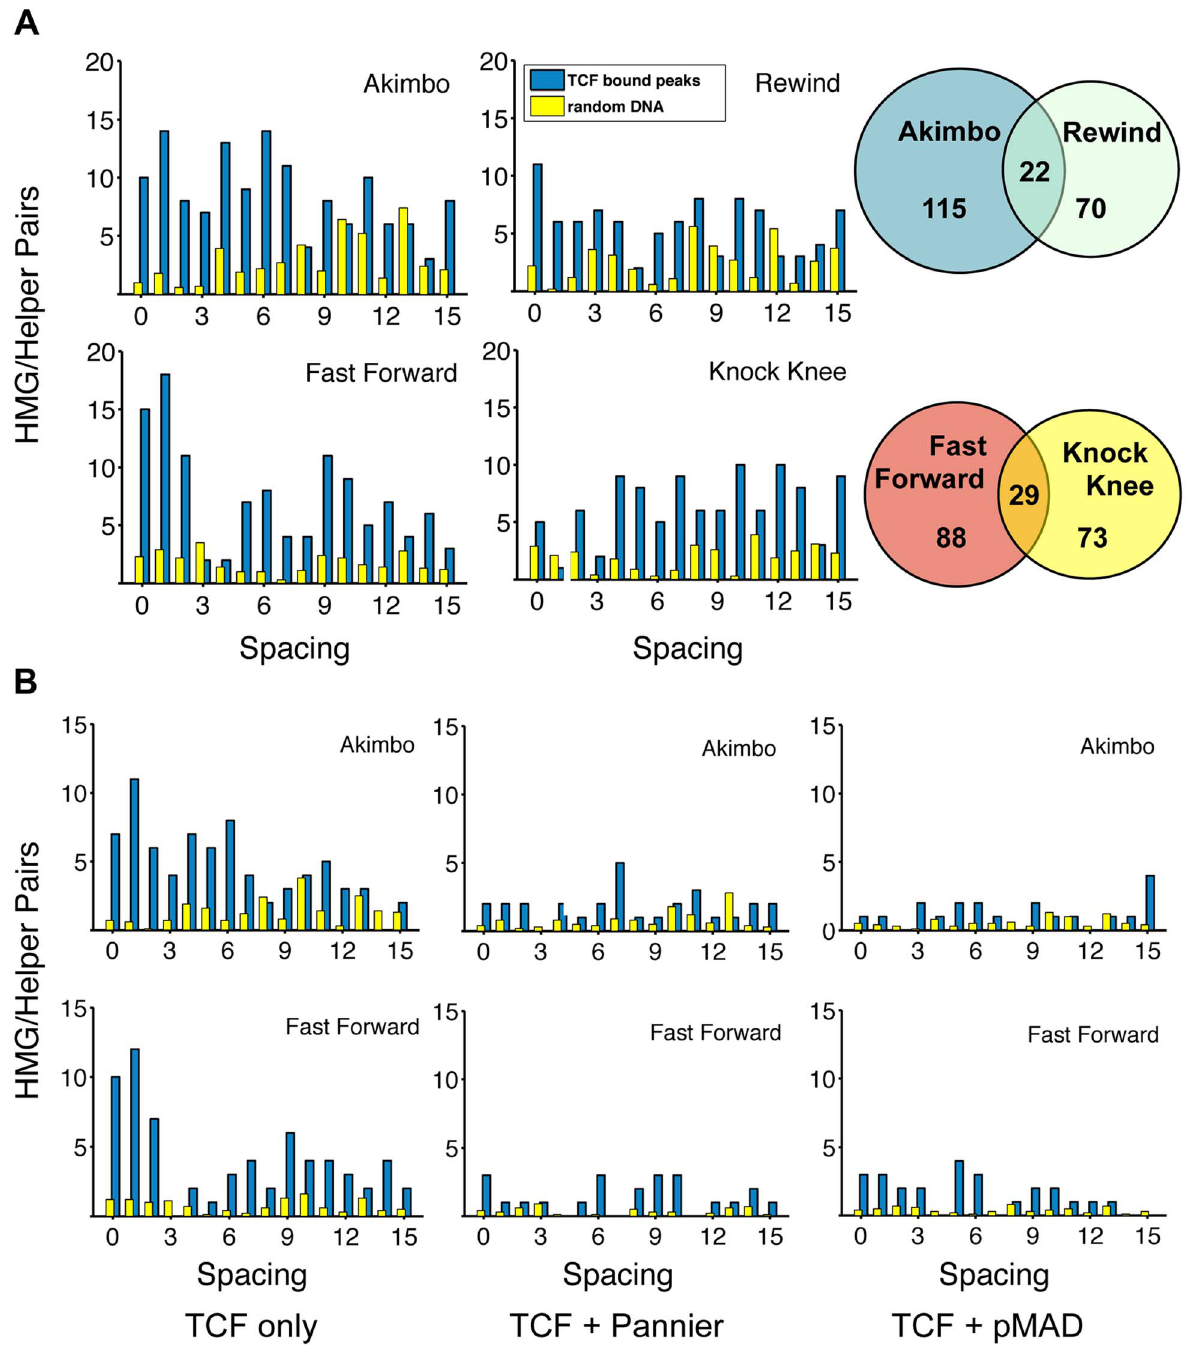
Figure 6. TCF/Pan-bound chromatin is enriched for HMG-Helper site pairs. (A) Distribution of HMG-Helper pairs in genomic sequences bound by TCF/Pan (blue bars) versus random DNA (yellow bars). TCF/Pan-bound sequences were obtained from a ChIP-seq data set from germband extended Drosophila embryos [28]. Equivalent amounts of random DNA from intergenic, intronic and 5 9 /3 9 UTR regions were analyzed, with the average of ten such runs displayed. Nearly all the HMG-Helper site configurations were enriched in TCF/Pan bound regions, with the highest degree of enrichment in FF0-2 and AK0-6. Due to the semi-palindromic nature of the Helper site, many sites with nucleotide mismatches were called as both AK/RW or FF/KK. The overlap is indicated in the Venn diagram to the right of each pair of graphs. (B) AK and FF motifs are highly enriched in peaks which are uniquely bound by TCF/Pan (see text for further explanation). Enrichment is less dramatic in TCF/Pan peaks that are shared by Pannier or indirectly effects expression of the W-CRM reporter. This is nearly complete loss of reporter expression (Figure 8B 9 ). In addition to its role in Wg signaling, Arm is also required for cell unlikely, because da Gal4 . UAS arm RNAi embryos were morpho- adhesion [69,70], raising the possibility that depletion of Arm logically normal at stage 13 and had normal expression of Wg